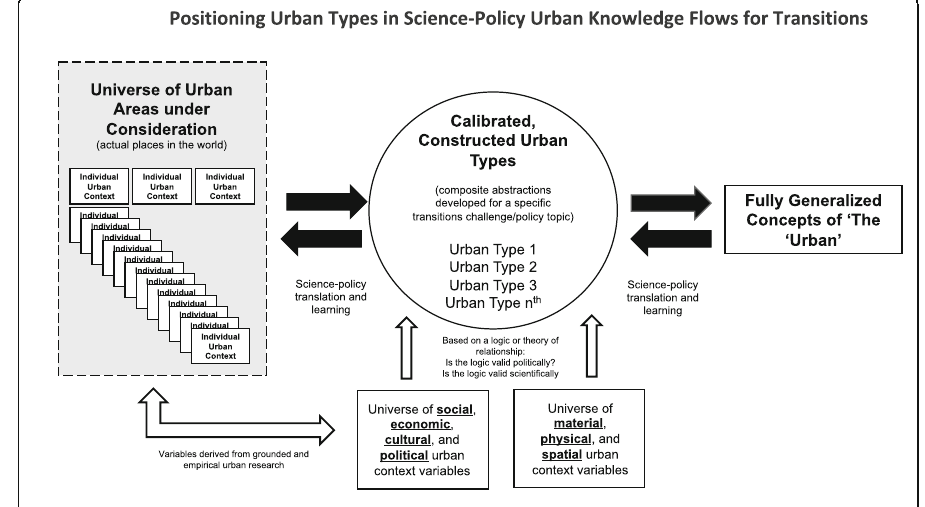
Fig. 1 Positioning Urban Types in Science-Policy Urban Knowledge Flows for